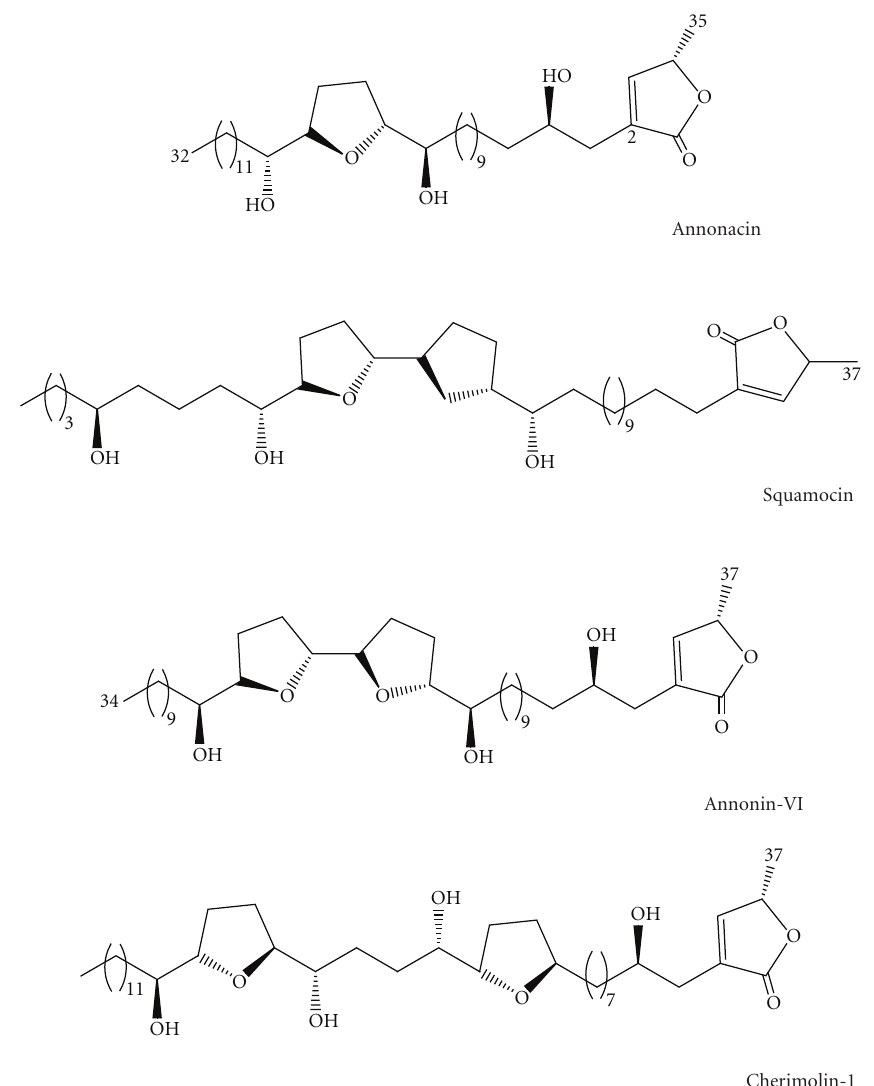
Figure 1: The chemical structure of ACGs